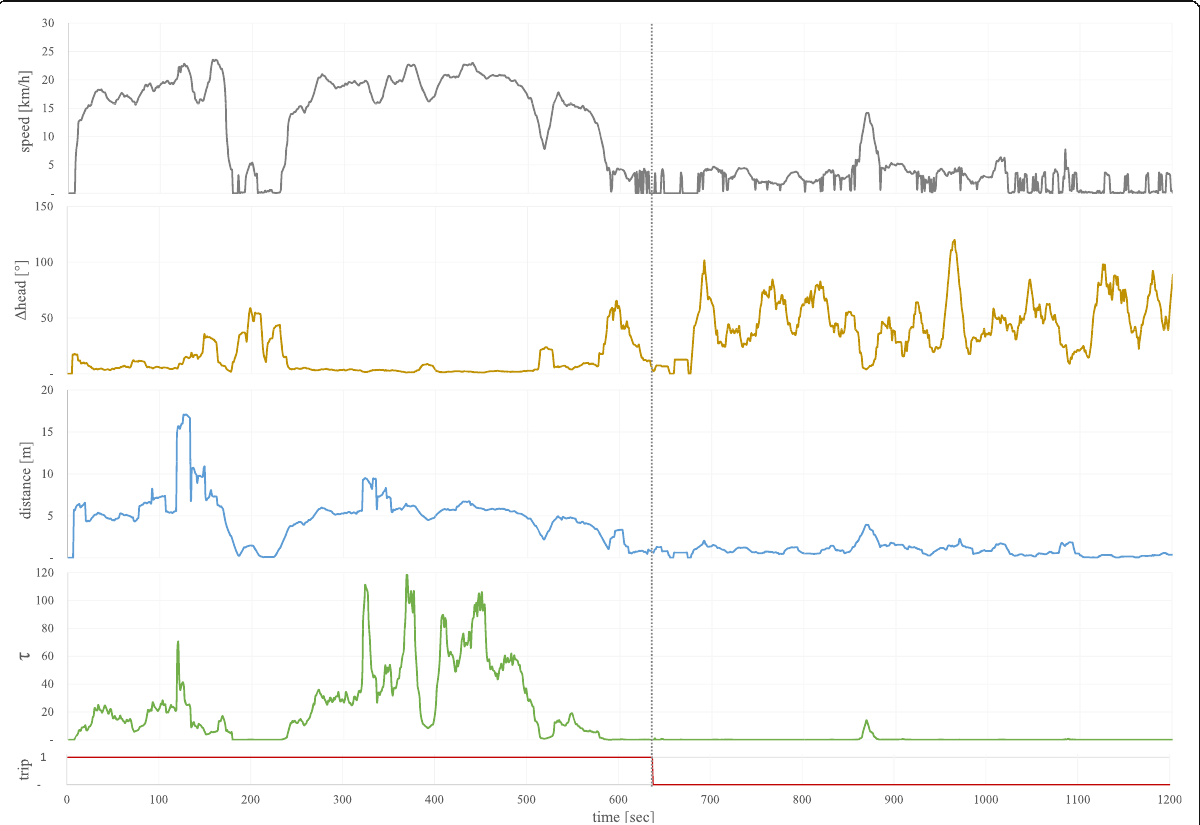
Fig. 4 Illustration of speed, heading, distance and TAU values over a trip and activity